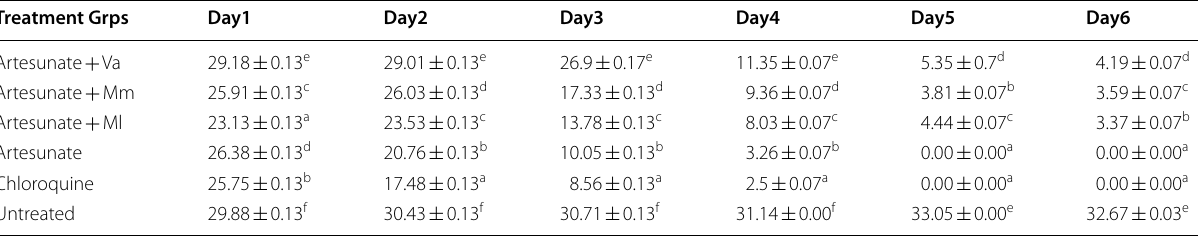
Table 3 Mean percentage parasitaemia of mice treated with combined therapy Treatment Grps